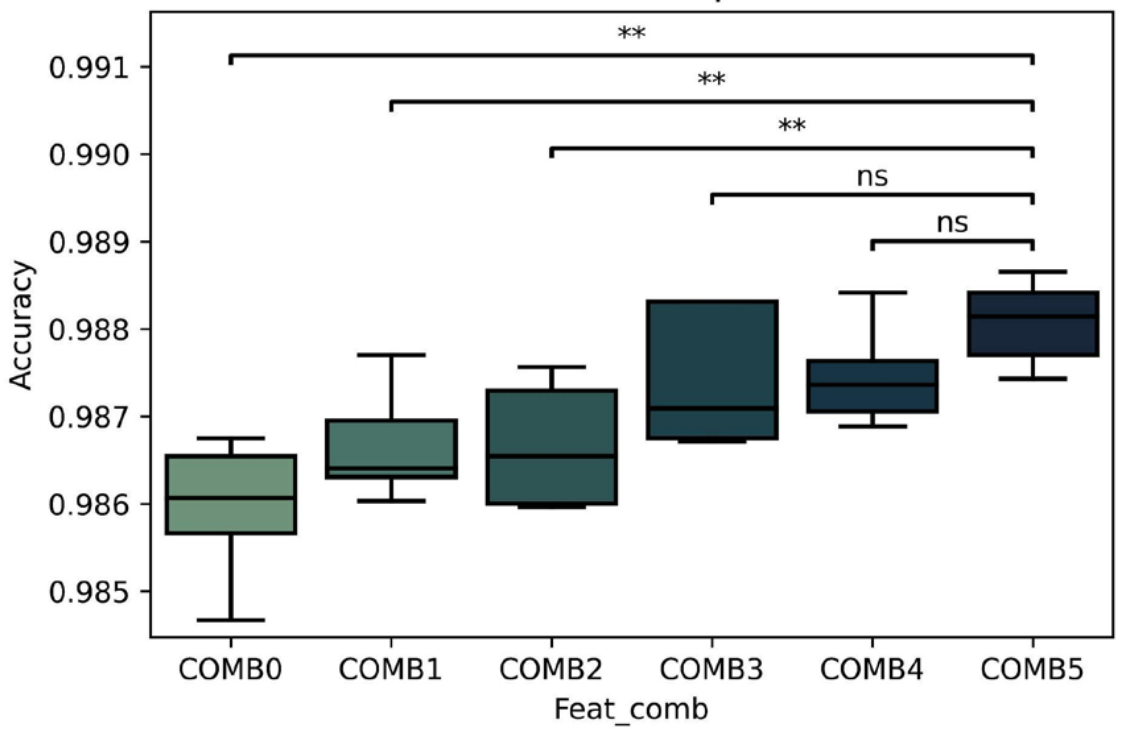
Figure 5. Accuracy comparison between non-linear selected features. COMB0 (PerEnt), COMB1 (PerEnt + SampEnt), COMB2 (PerEnt + SampEnt + SVDEnt) COMB3 (PerEnt + SampEnt + SVDEnt + DFA) COMB4 (PerEnt + SampEnt + SVDEnt + DFA + SpectEnt), COMB5 (PerEnt + SampEnt + SVDEnt + DFA + SpectEnt + Higuchi); p -value annotation legend: ns: non-significant; ** p < 0.01.